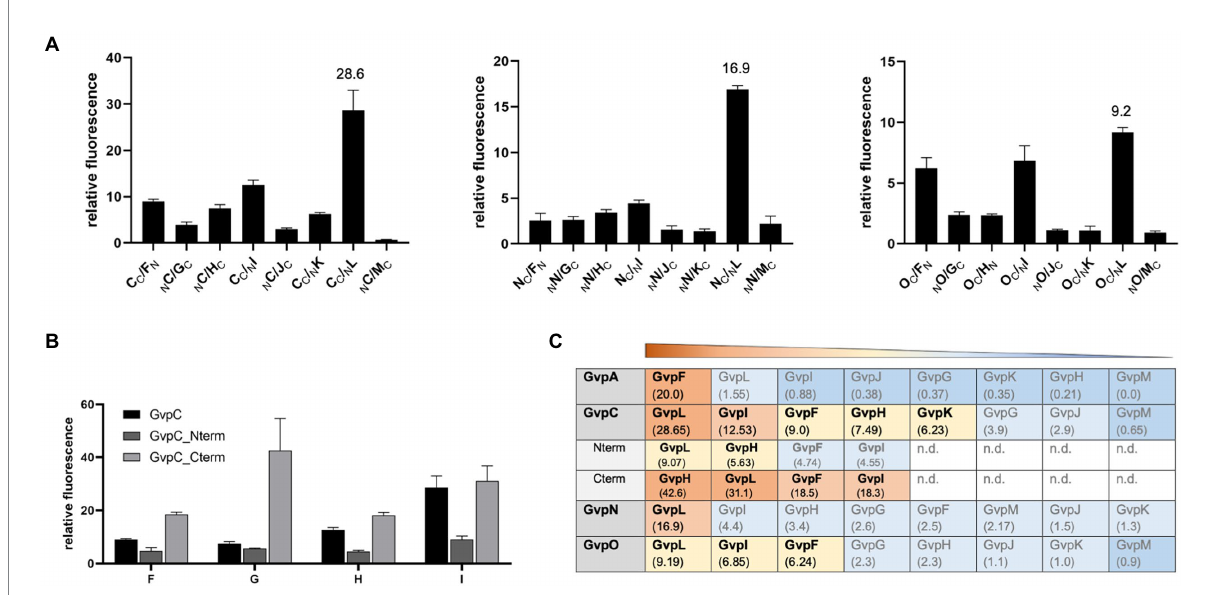
FIGURE 6 Spilt-GFP analysis of GvpC, N, and O with GvpF through GvpM. (A) The three graphs show the relative fluorescence obtained with C/ − , N/ − , and O/F through M transformants. (B) Relative fluorescence of GvpC or GvpC fragments Cterm and Nterm with GvpF, H, I, or L. (C) Overview of the rf values obtained for each of these interactions. The interacting Gvp proteins are ordered by rf values and shaded in red, rf > 10; yellow, rf < 10 to >5; blue, rf < 5; or dark blue, rf < 1; n.d., not